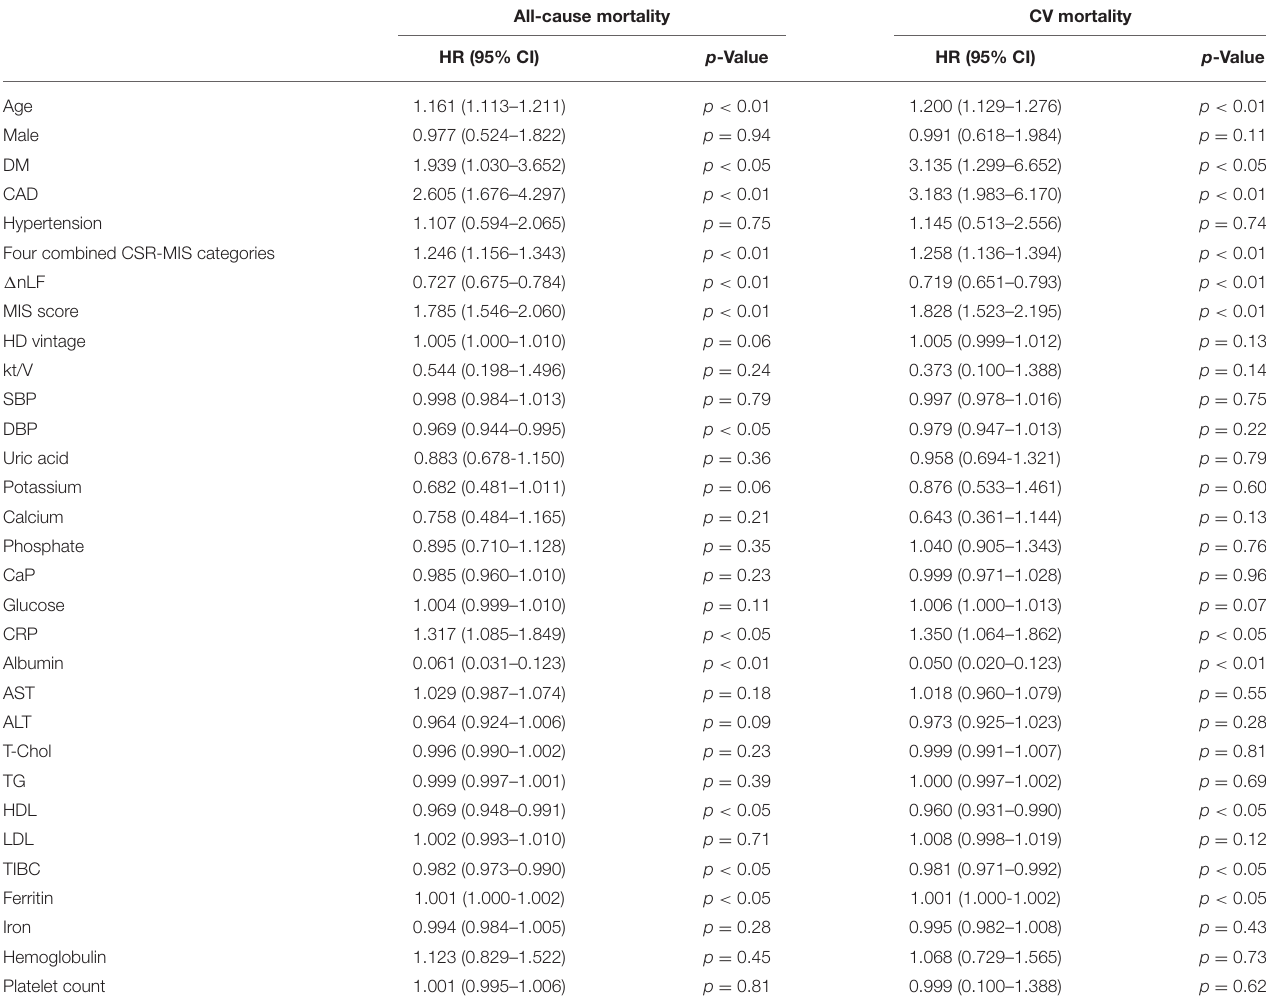
TABLE 3 | Univariate Cox regression analysis of prognostic factors for all-cause and CV mortality.